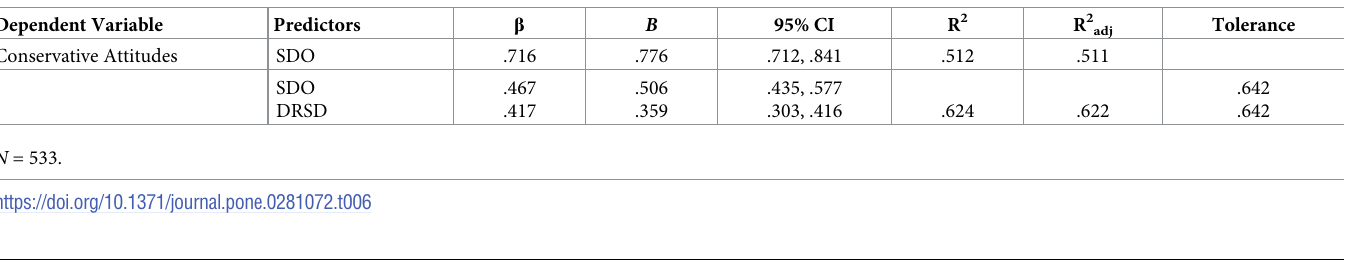
for transparency. The 9-item short scale showed a relatively good fit to a one-factor solution (CFI = .962, TLI = .949, RMSEA = .112), however, one item did not seem to fit the factor (this was the case for both the 14-item and short scale), so it was excluded from further analyses. The 8 remaining items showed good fit to a one-factor solution (CFI = .974, TLI = .963, RMSEA = .105). The SRMR for both models looked proper according to Hu and Bentler [55], with SRMR = .031 for the 9-item model and even better for the 8-item model with SRMR = .021. Overall, the CFA supported the notion of the scale as a one-dimensional measurement. Correlates of DRSD. To test Hypotheses 1 a)-c), correlations between the relevant vari- ables were calculated (see Table 5). Correlations indicated again that participants scoring higher on the DRSD scale also showed higher scores of RWA ( r = .524, p < .001) and SDO (r = .598, p < .001). The same can be said for the reactivated f-scale ( r = .676, p < 001). Participants exhibiting higher scores of DRSD also showed a stronger preference for Republican politicians ( r = -.760, p < .001; the negative correlation is obviously due to the calculation of the prefer- ence score), self-identification as more right ( r = .591, p < .001) and more conservative ( r = .587, p < .001). Hypotheses 1 a)-c) were supported. Again, to provide further evidence in support of our validity analyses, we performed a Har- man’s single factor test to investigate potential common method bias. The resulting single fac- tor explained about 32% of variance, suggesting that common method bias is not a concern. Predicting conservative political orientation. To test Hypothesis 2, we conducted a lin- ear regression with DRSD and SDO as the predictors and the 17-item political attitudes scale as the dependent variable. The model was significant, explaining 62.4% of variance ( F (2, 530) = 439.542, p < .001). SDO ( β = .467; t (530) = 14.039, p < .001) and DRSD ( β = .417; t (530) = 12.533, p < .001) were both significant predictors of conservative political orientation. When this is calculated as a hierarchical regression with DRSD being added in step 2, the addition of DRSD as a predictor explains a significant 11.1% of variance in addition to SDO (change in F (1, 530) = 157.088, p < .001). We, therefore, found confirming evidence for Hypothesis 2 (for all regression analyses see Table 6).